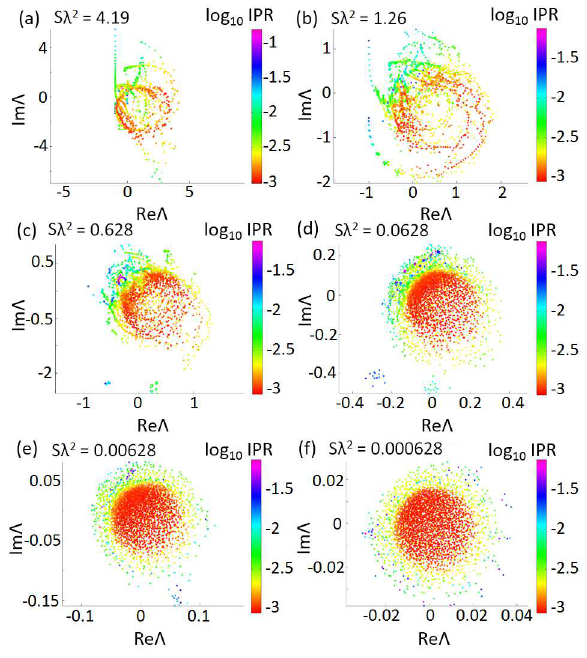
Figure 11. Eigenvalue distributions of the dyadic Green’s matrix in the complex plane for N = 1000 π -spiral array with ( a ) S λ 2 = 4.19; ( b ) S λ 2 = 1.26; ( c ) S λ 2 = 0.628; ( d ) S λ 2 = 0.0628; ( e ) S λ 2 = 0.00628; ( f ) S λ 2 = 0.000628. The color bar shows the inverse participation ratio (IPR) of the eigenmode associated to each eigenvalue in log